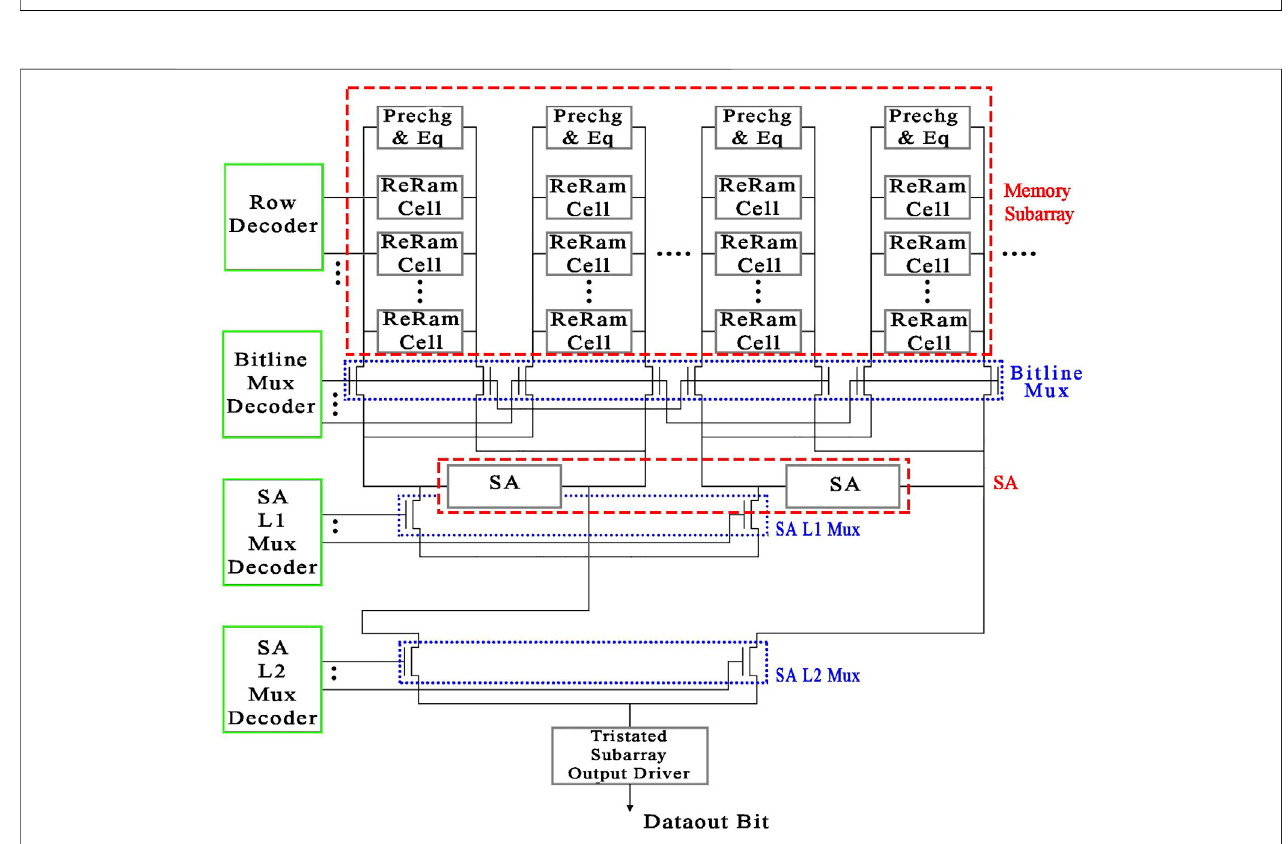
FIGURE 3 | Peripheral circuitry associated with bitlines in the